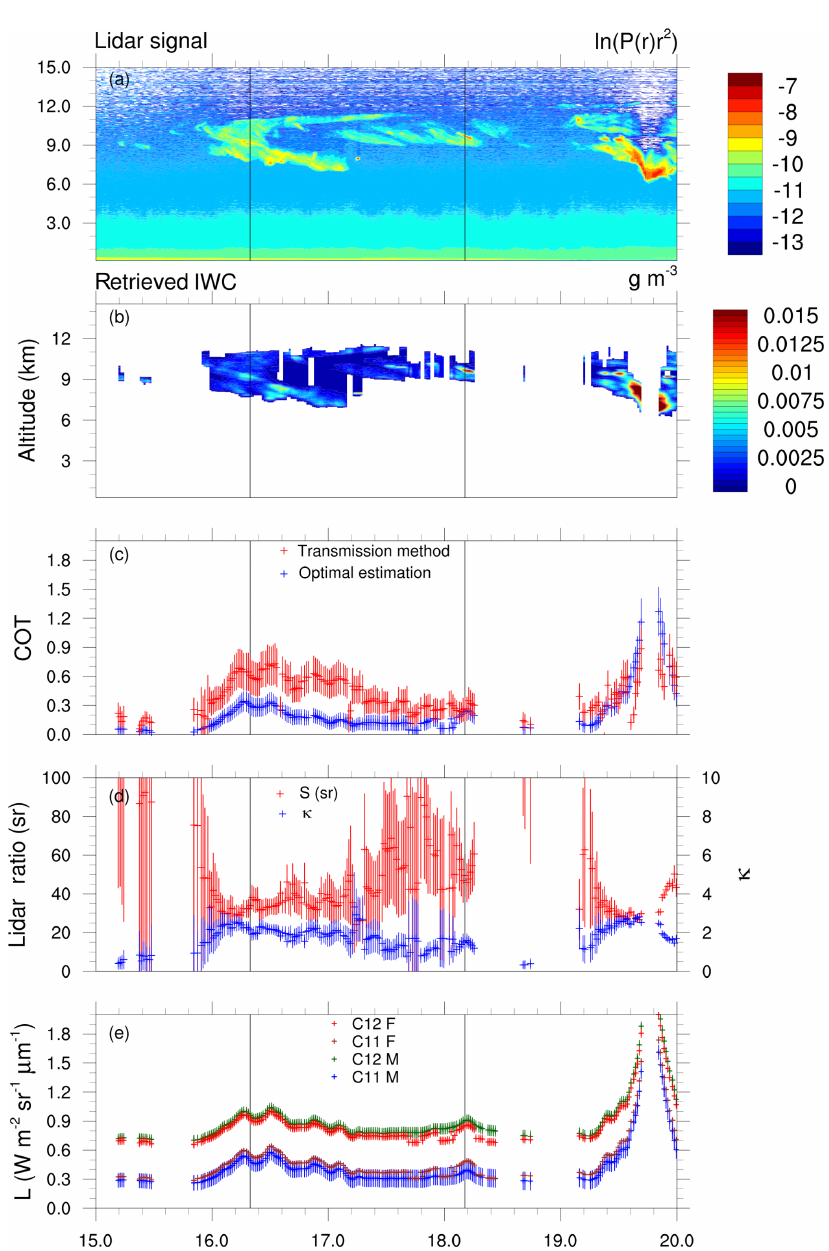
Figure 12. Retrieval results of the synergy algorithm for 30 November 2016, 15:00 to 20:00UTC. (a) Logarithm of the measured range- corrected lidar signal. (b) Retrieved IWC profiles. (c) Retrieved factor κ (right axis, represented by blue crosses) and the corresponding lidar ratio in steradians (left axis, represented by red crosses). (d) COT from the synergy algorithm (blue) and from the transmission method (red). (e) Thermal infrared radiometer measurements (C11 M and C12 M) and the converged forward model results (C11 F and C12 F), expressed as normalized